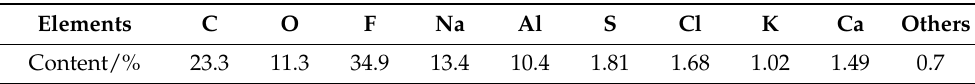
Table 2. Elemental analysis of carbon dust.